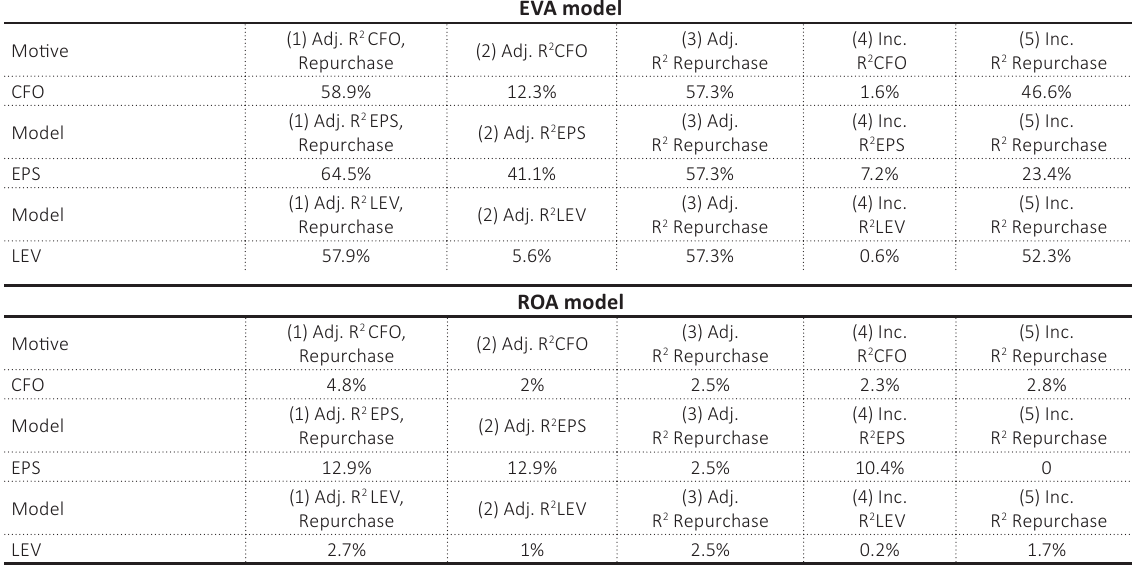
Table 10. Incremental explanatory ability for share repurchases motives on financial